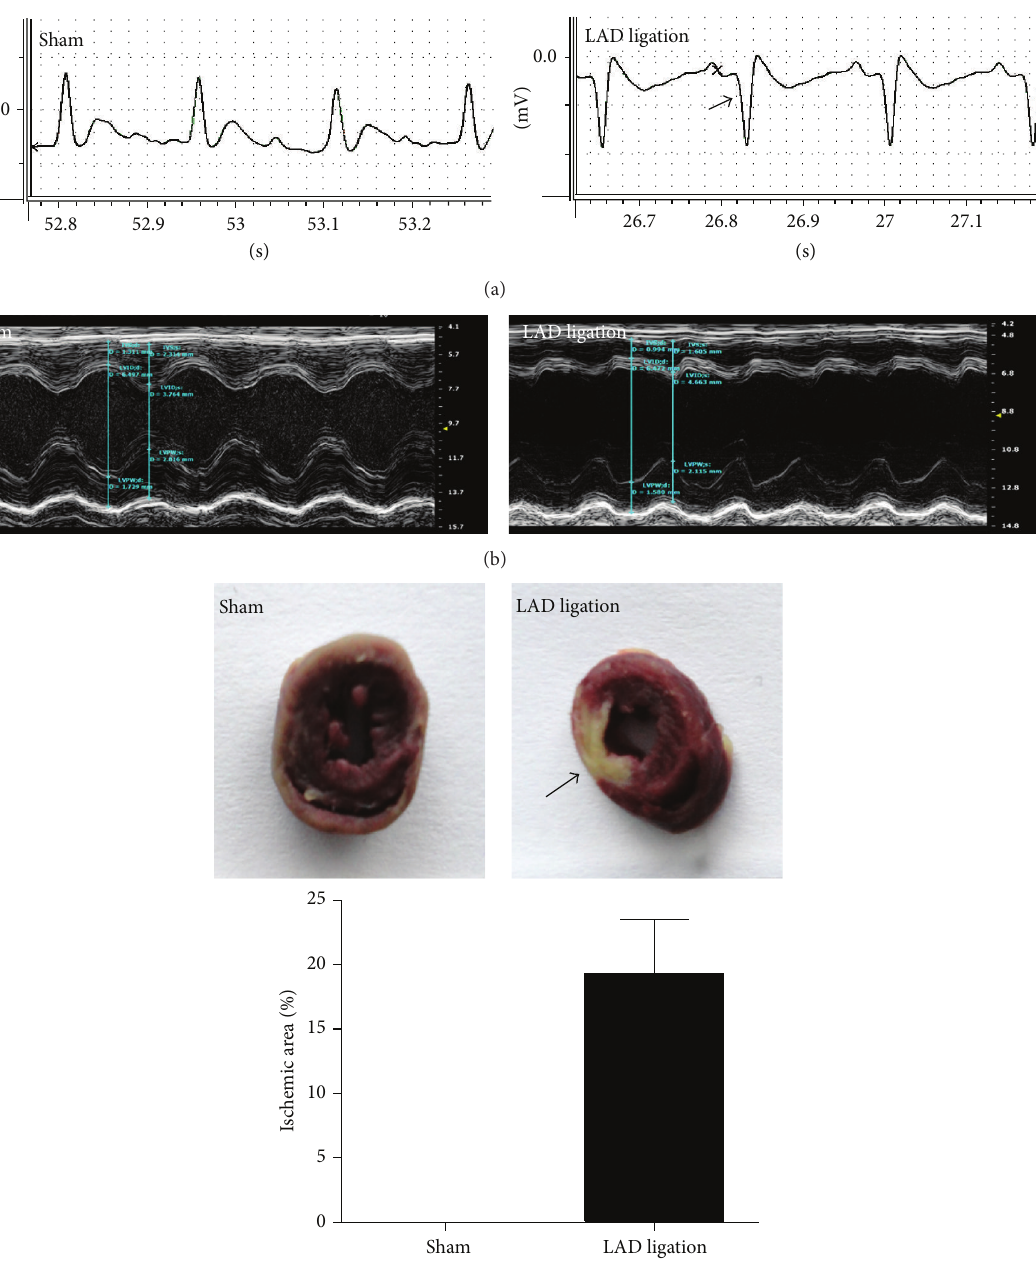
Figure 3: Establishment of a rat AMI model. Electrocardiogram of rats (a). A normal wave can be seen in the sham group. Arrow indicates the pathologic Q wave in an LAD ligated rat. The representative echocardiography (b). A sham rat shows a normal cardiograph. Contraction of the left ventricle anterior walls in the LAD ligated animal was weaker than in sham control animal. TTC staining of a myocardial